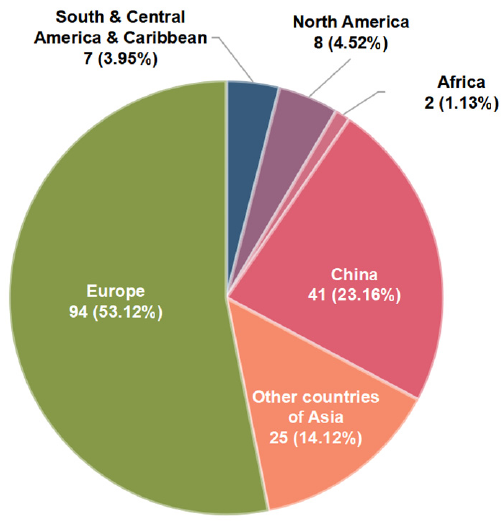
Figure 1. Distribution of the number of UGGps by continent.